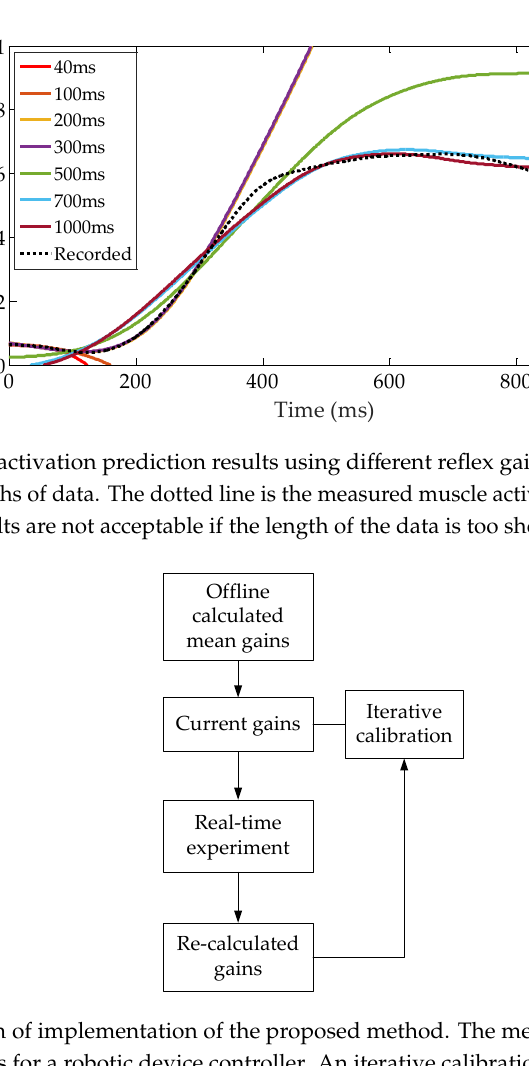
Figure 16. Diagram of implementation of the proposed method. The mean values of reflex gains are used as initial gains for a robotic device controller. An iterative calibration is applied to modified the reflex gains.